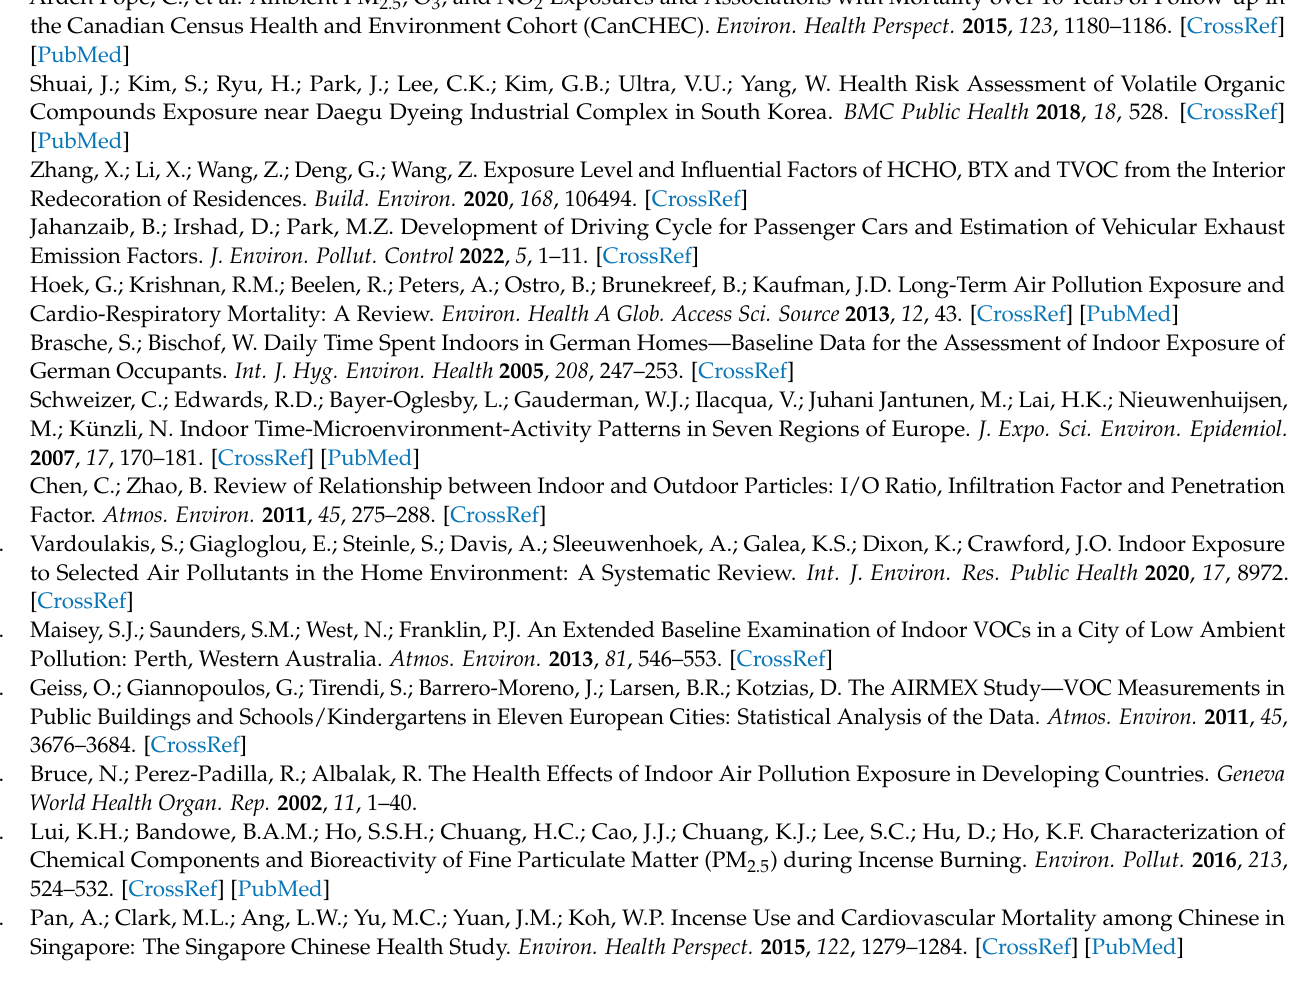
Figure S5: Correlation values of outdoor and indoor PM 10 and PM 2.5 for APT IV (without ventilation and indoor plants). Table S1: Values of various indoor pollutants inside various